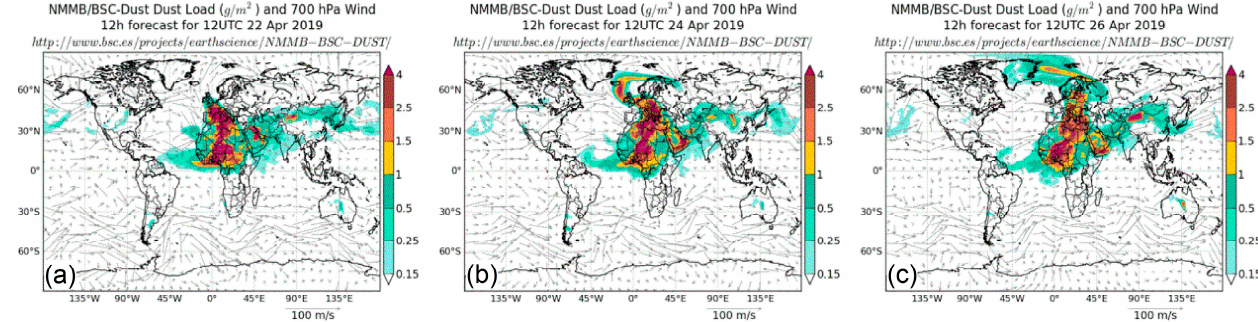
Figure 3. Global-scale NMMB/BSC-Dust model results for the dust load and the 700 hPa wind field at 12 h forecast for 12 UTC on ( a ) 22 April 2019, ( b ) 24 April 2019, and ( c ) 26 April 2019.